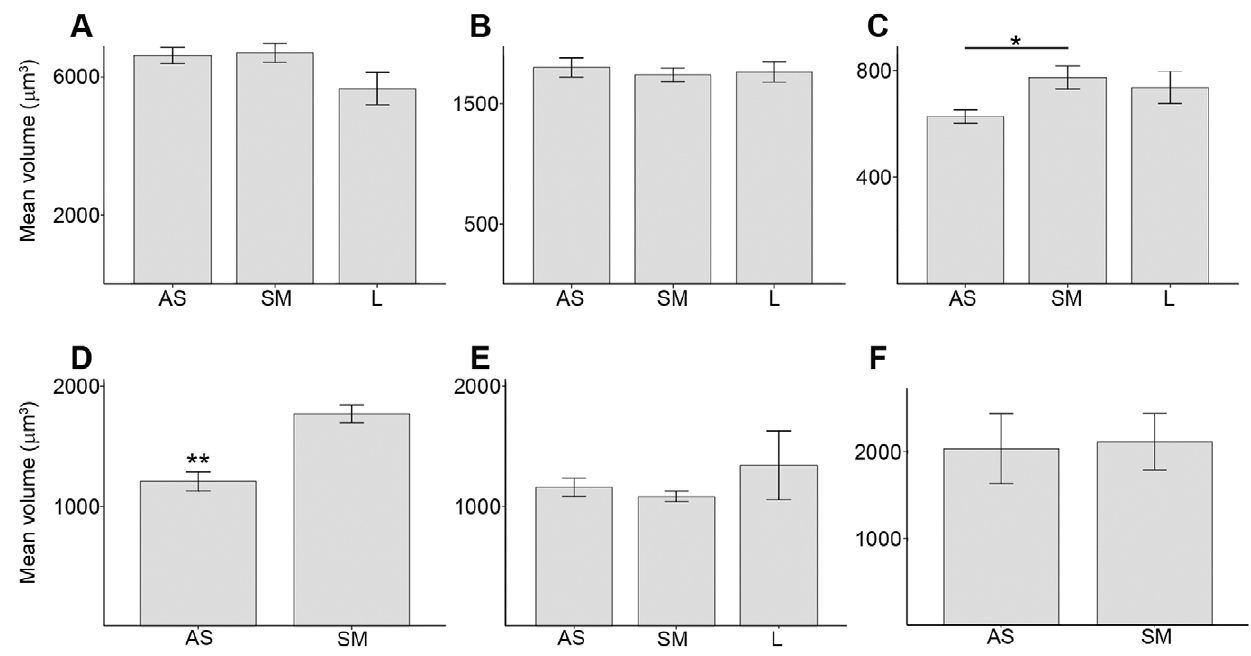
Figure 2. Mean volume of the soma. Bar graphs showing the mean volume of the soma for CR-ir (A, large; B, medium; C, small), PV-ir (D), CB-ir (E) interneurons and TH-ir cells in the human striatum. The only statistical differences were found for the small group of CR-ir cells (*, 0.05 . P . 0.01) and for PV-ir interneurons (**, P , 0.01). Error bars indicate the SEM. AS, associative; L, limbic; SM, sensorimotor.